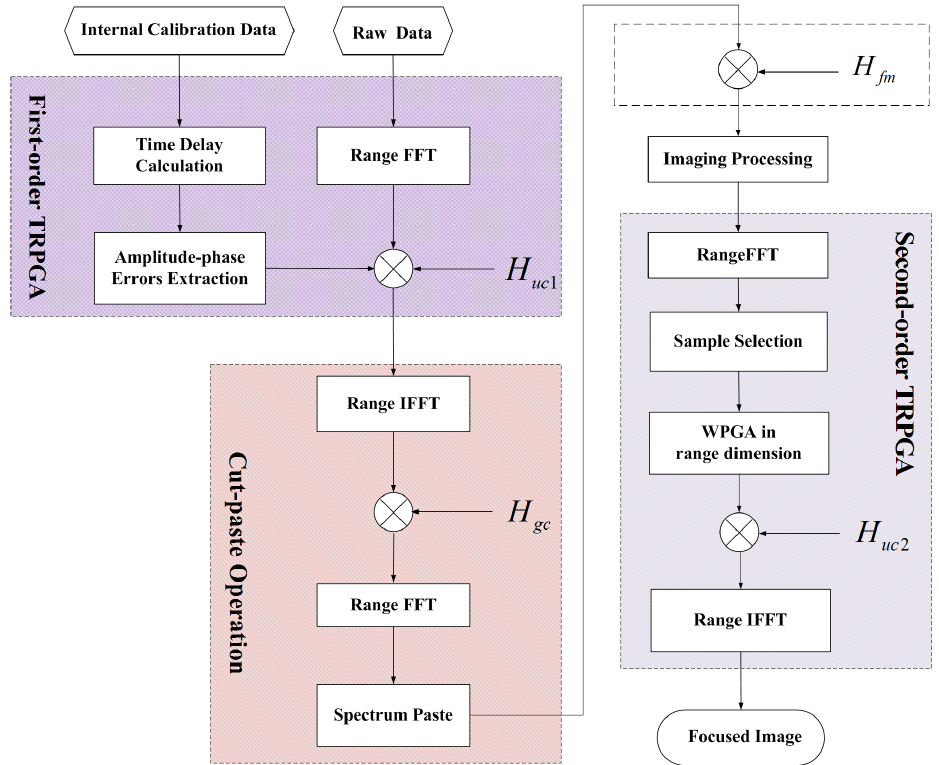
Figure 6. Flow diagram of the proposed